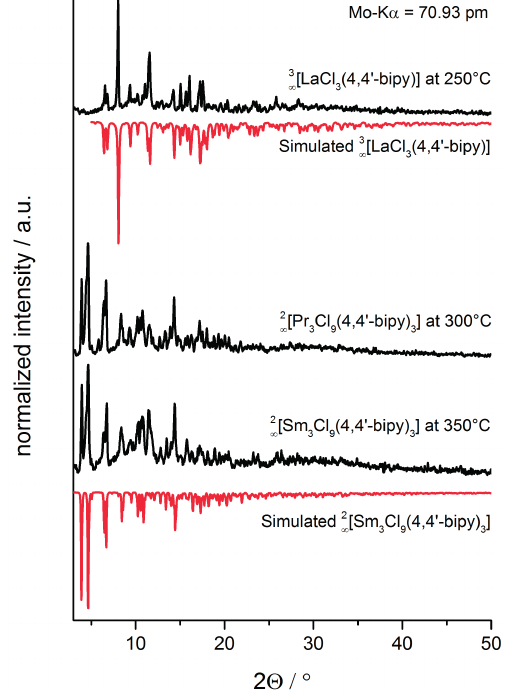
Figure 5. Comparison of the diffraction patterns of 8 and 9 by temperature-dependent XRPD investigations and the simulated diffraction patterns based on single-crystal